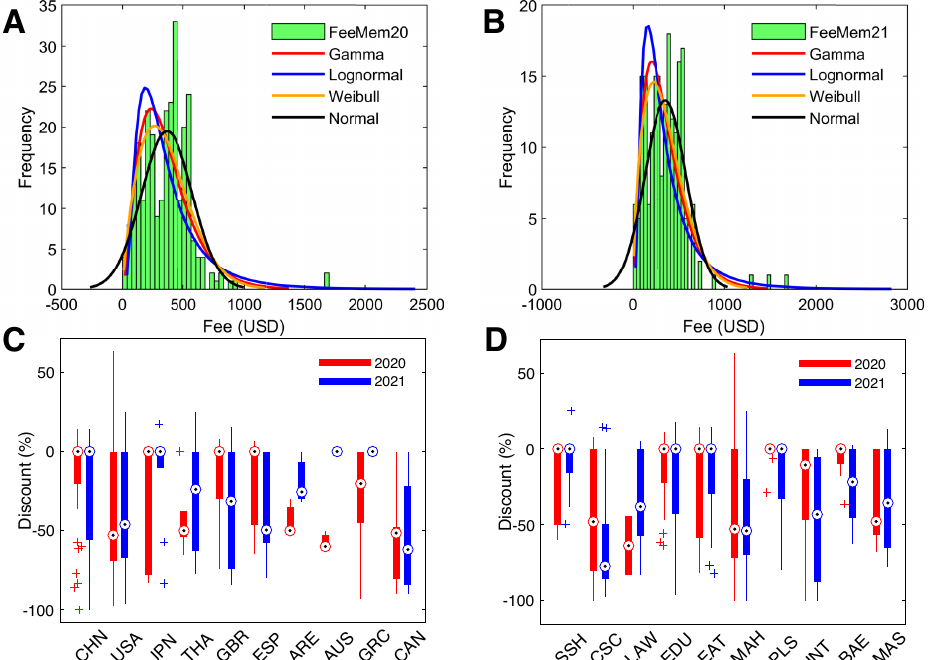
Figure 2. Statistical results of the registration fees and discounts for virtual conferences held in 2020 and 2021. ( A , B ) The distributions of the registration fees for members of virtual conferences, respectively, held in 2020 and 2021. ( C , D ) The distributions of the discounts of registration fees for members of virtual conferences held in 2020 and 2021 with respect to the top 10 countries and the 10